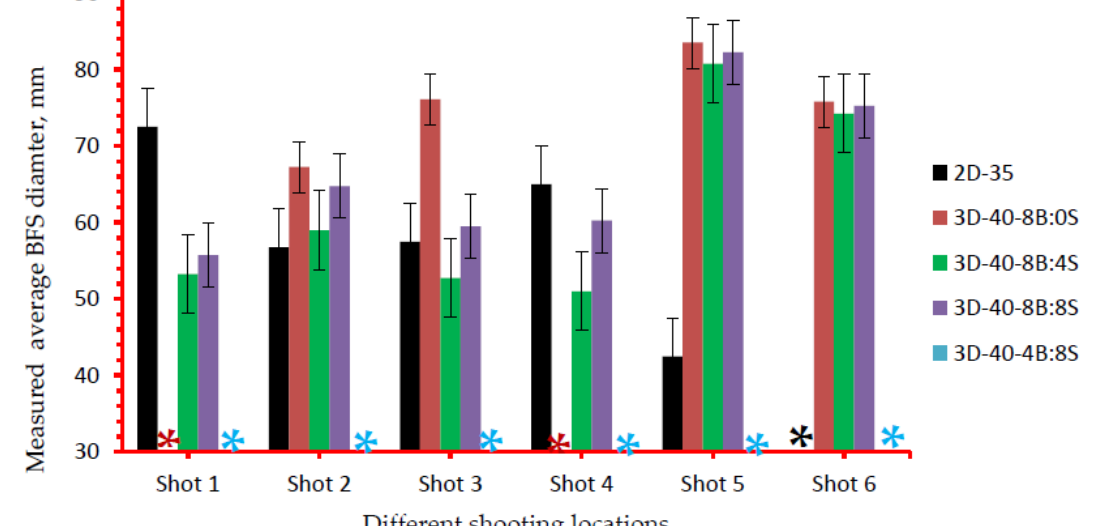
Figure 11. Measured averaged BFS diameter for different 3D warp interlock variants and 2D plain weave para-aramid fabrics at different shoot locations. (* All shots were penetrated for 3D-40-4B:8S,* shot 6 penetrated sample 2D-35 and * shot 1 & 4 penetrated sample 3D-40-8/0).